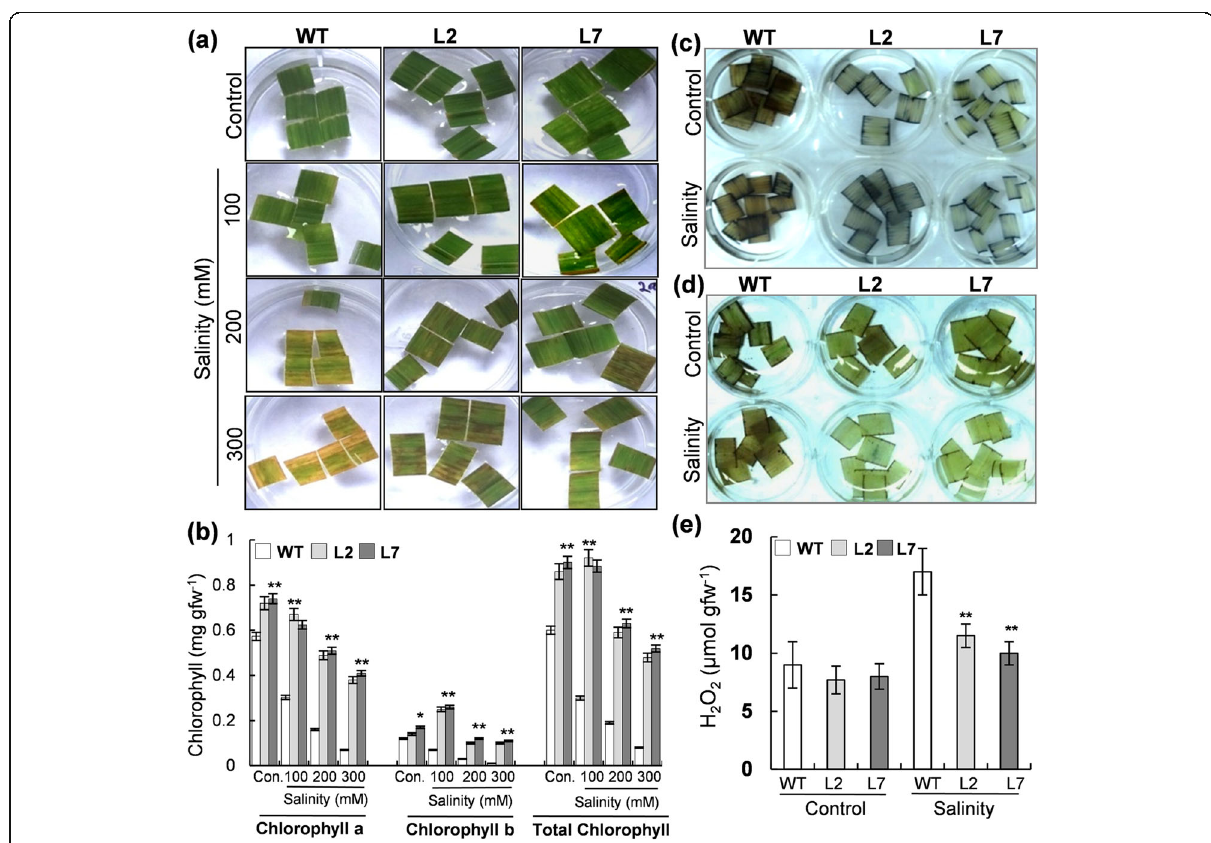
Fig. 2 Leaf segment-assay showing NaCl-induced senescence in rice leaves through analysis of chlorophyll and ROS (O 2 − and H 2 O 2 ) content. a OsHBP1b over-expressing plant (L2 and L7) and WT plant leaf segments were kept in control (no NaCl) or different concentrations (100, 200 and 300 mM) of NaCl solution and pictures were taken after 72h. The L2 and L7 leaves showing delayed leaf senescence as compared to the wild type leaves. b Chlorophyll contents (Chl- a , Chl- b and total Chl) in WT and transgenic rice leaf segments after 72h of NaCl treatment. c Constitutive and salinity induced levels of O 2 − were measured by NBT staining in WT and. d Salinity- induced H 2 O 2 content were measured by DAB staining in WT and OsHBP1b over-expressing plants measured through spectrophotometer. Error bars show OsHBP1b over-expressing plants. e H 2 O 2 content in WT and standard error from triplicate experiments. Single asterisk show significant difference at p <0.005 and double asterisk at p